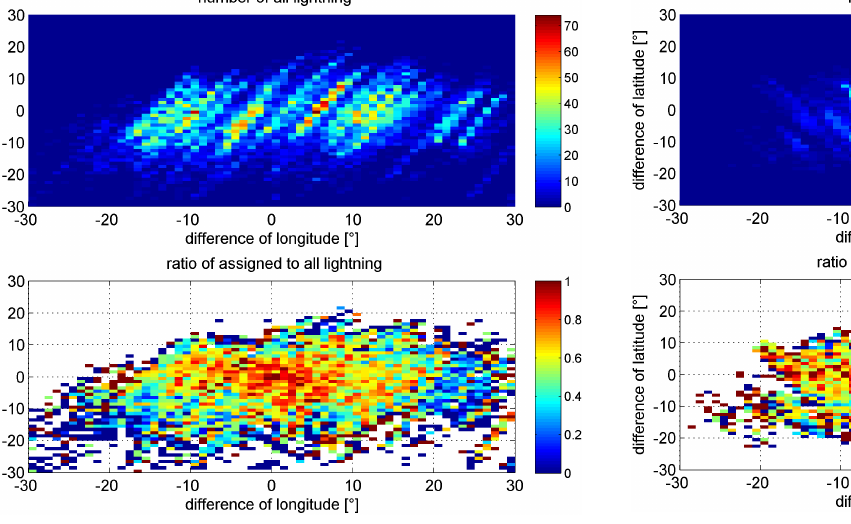
Fig. 5. Top: number of all lightning detected by the EUCLID net- work as a function of longitudinal and latitudinal difference be- tween the magnetic footprint and locations of lightning. Bottom: Ratio of the assigned to all lightning (nighttime